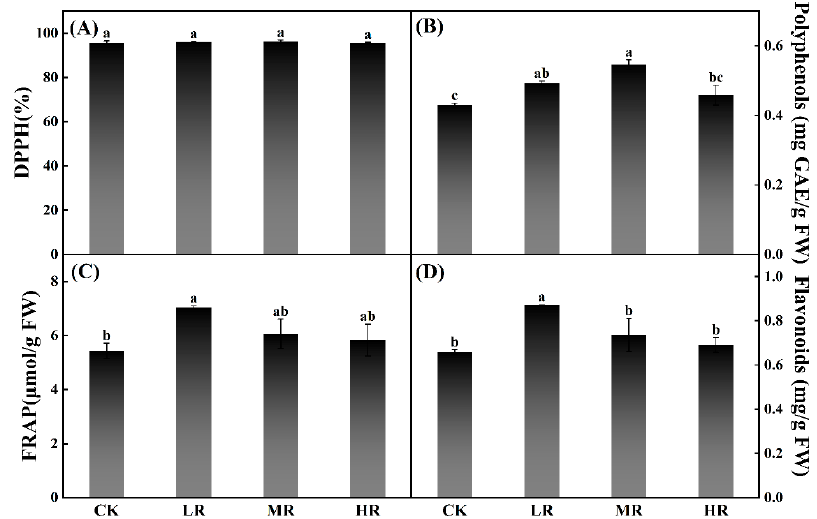
Figure 5. CK: only white light, LR: red:white = 1:2, MR = red:white = 1:1, LR = red:white = 2:1. DPPH ( A ), polyphenols content ( B ), FRAP ( C ), and flavonoid content ( D ) of pak choi grown under the different ratios of red and white light treatments. All values are expressed as mean ± standard error ( n = 3). The letters marked in all figures indicate the significance of the difference ( p ≤ 0.05, Duncan’s test).